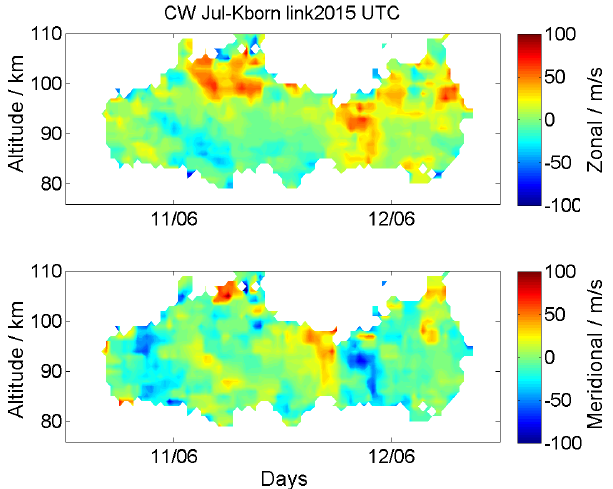
Figure 7. Zonal and meridional wind derived from the CW exper- iment using the forward scatter radio link between Juliusruh and